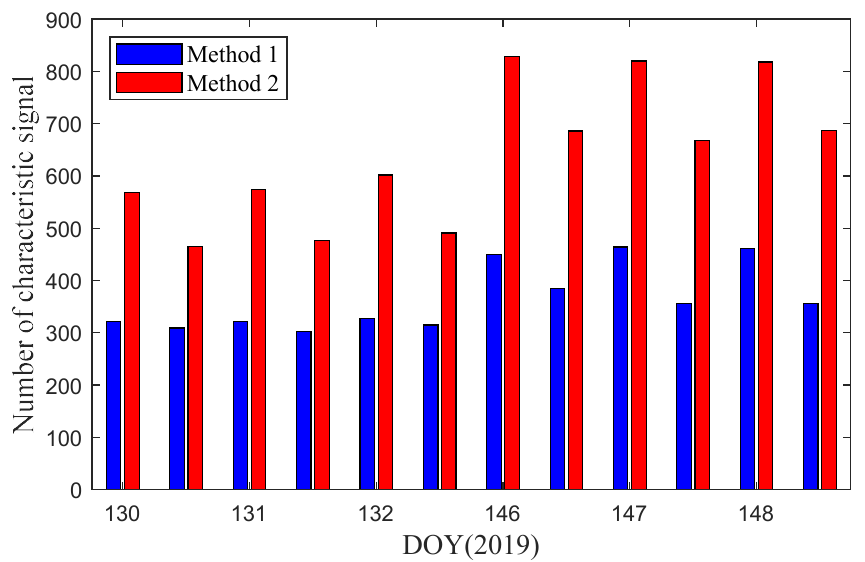
Figure 8. Number of characteristic signals used for different tomography methods at UTC 00:00 and 12:00 during the experimental period from DOY 130–132, 2019, and DOY 146–148, 2019.